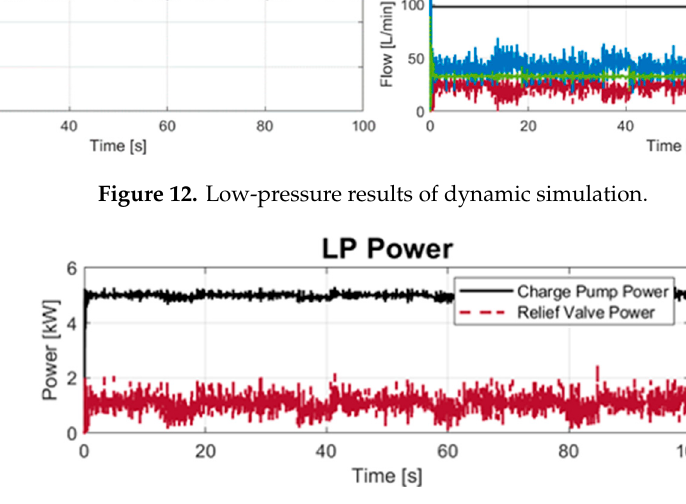
Figure 13. Low-pressure power consumption.